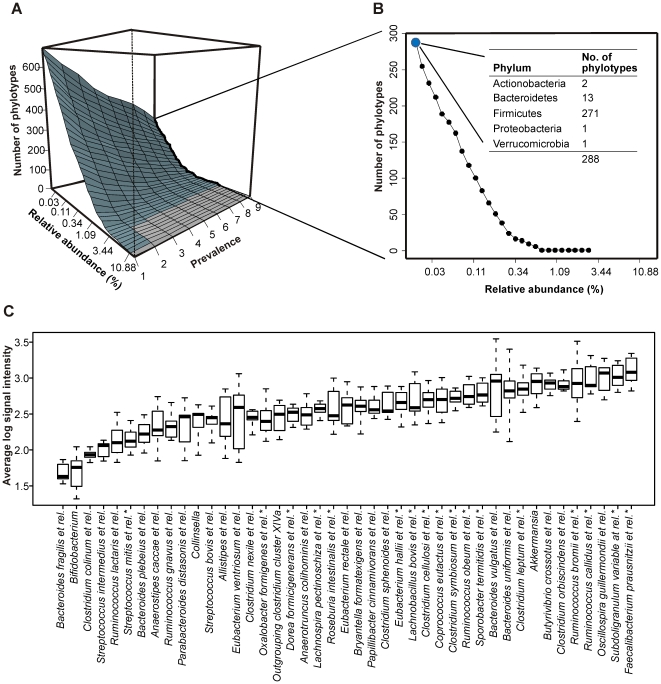
Definition of the common core microbiota.
A. Perspective plot is used to visualize how the number of phylotypes in the common core is a function of the selected abundance and prevalence. Light gray indicates the area where no phylotypes passed the given criteria. B. The common core microbiota in the healthy subjects. The y-axis represents the range of the phylotype count shared, thus forming the common core, in the nine healthy subjects. The line visualizes how the number of the phylotypes depends on the selected percentile abundance, and how it decreases drastically when the phylotypes with lowest abundance are excluded. List shows phylum-level summary of the phylotypes that contributed with over 0.03% relative abundance C.
The common core phylotypes summarized to genus-level taxa. The boxplots visualize the intra-individual variation in the abundances of the core taxa. Bacteroides fragilis et rel. and Bifidobacteria (two leftmost boxes) are visualized for reference purposes. These taxa were not part of the common core due to their large intra- and inter-individual variation. For boxplot details, please see the legend for Figure 4.